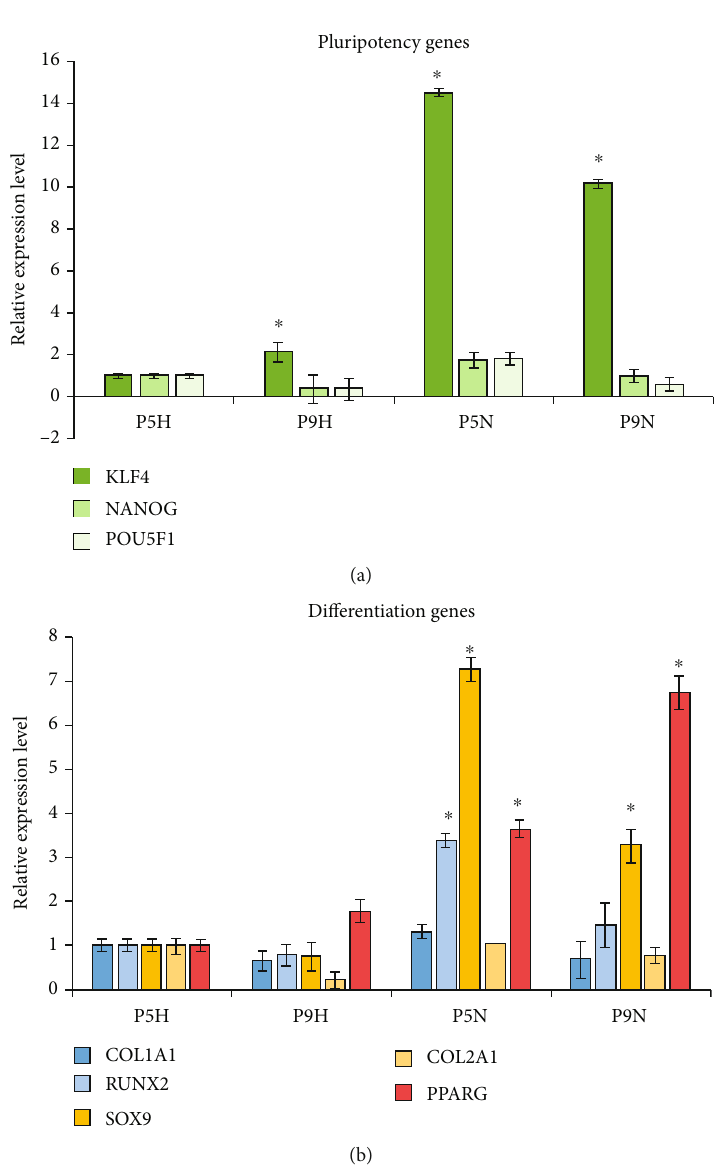
Figure 1: Relative gene expression levels by qRT-PCR for cells cultured under hypoxia and normoxia. (a) qRT-PCR for pluripotency genes KLF4 , NANOG , and POU5F1. (b) qRT-PCR for MSC di ff erentiation genes; osteogenic markers COL1A1 and RUNX2 , chondrogenic markers SOX9 and COL2A1 , and adipogenic marker PPARG . Relative expression levels are expressed using the GAPDH as the reference gene, and values were normalized to P5H; error bars represent SD. Statistically signi fi cant di ff erence, p < 0 : 05 , shown by ∗ for relative expression level when compared to P5H